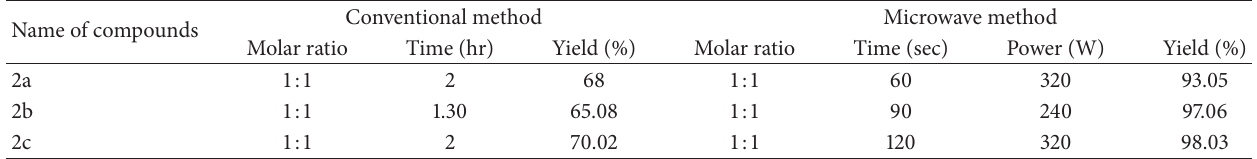
Table 1: Comparative study for synthesis of arylidene acetophenones. Name of